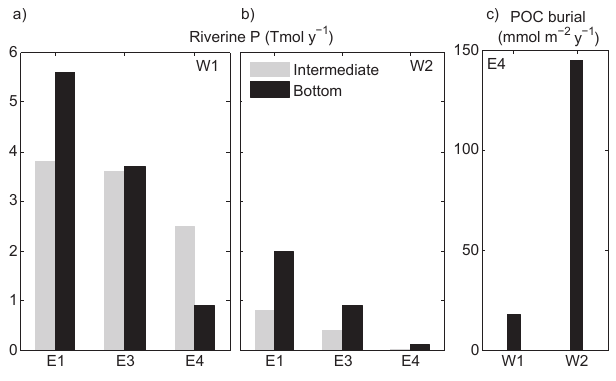
Fig. 5. Riverine P input required for anoxia in (a) the central open ocean (W1) and (b) the southern open ocean (W2) when the Pacific bottom water is well oxygenated (E1) and when oxygen is reduced to 130µmolL − 1 (E3) and to 0µmolL − 1 (E4). (c) POC burial in the open ocean when anoxic water enters the proto-North Atlantic from the Pacific Ocean